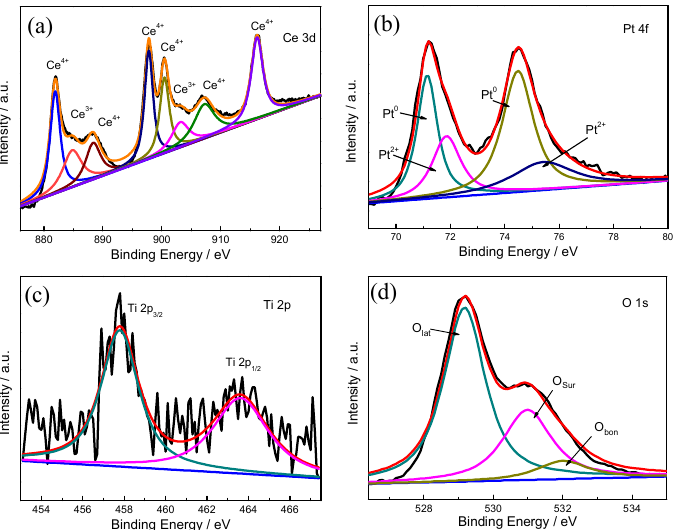
Figure 2. XPS spectra of ( a ) Ce 3d, ( b ) Pt 4f, ( c ) Ti 2p, and ( d ) O 1s of the (0.5TiO 2 − Pt)/CeO 2 cata- lyst.